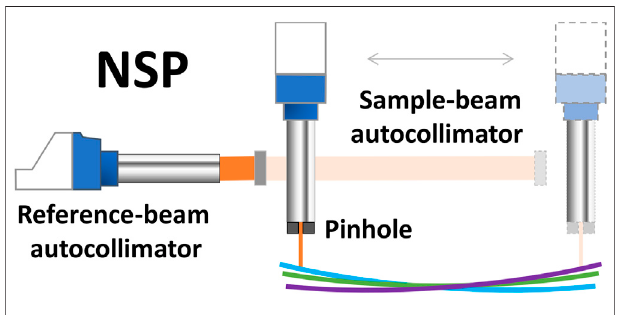
FIGURE 1 | The schematic diagram of the multi-pitch NSP